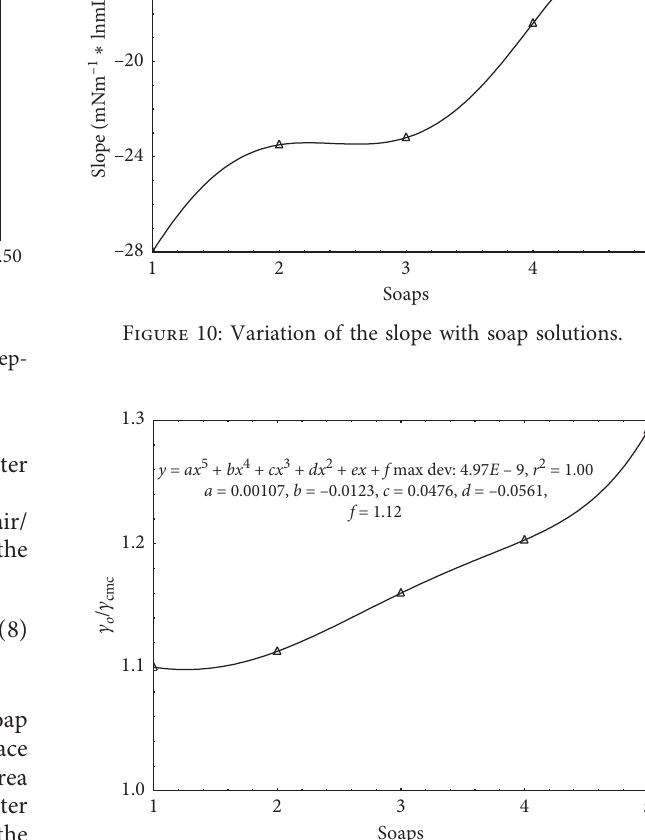
Figure 11: Variation of ( c